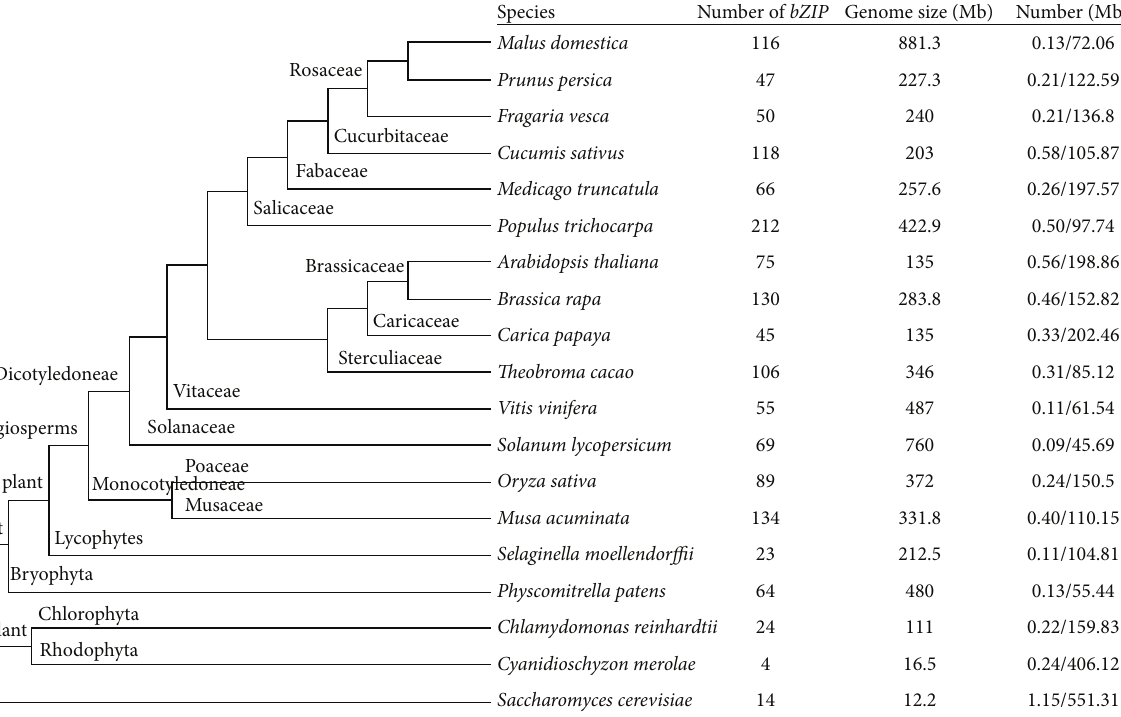
Figure 1: Phylogenetic relationships, number of bZIP genes, genome size, bZIP density, and overall gene density of the nineteen species analyzed. The bZIP density and overall gene density of the nineteen species analyzed were separated by parenthesis. The bZIP density was followed by overall gene